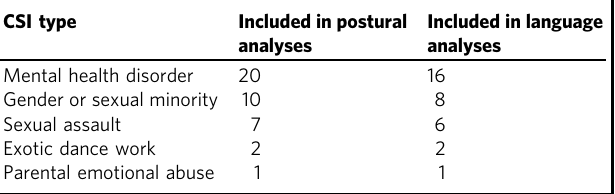
Table 1 Number of participants with each CSI type included in postural and language